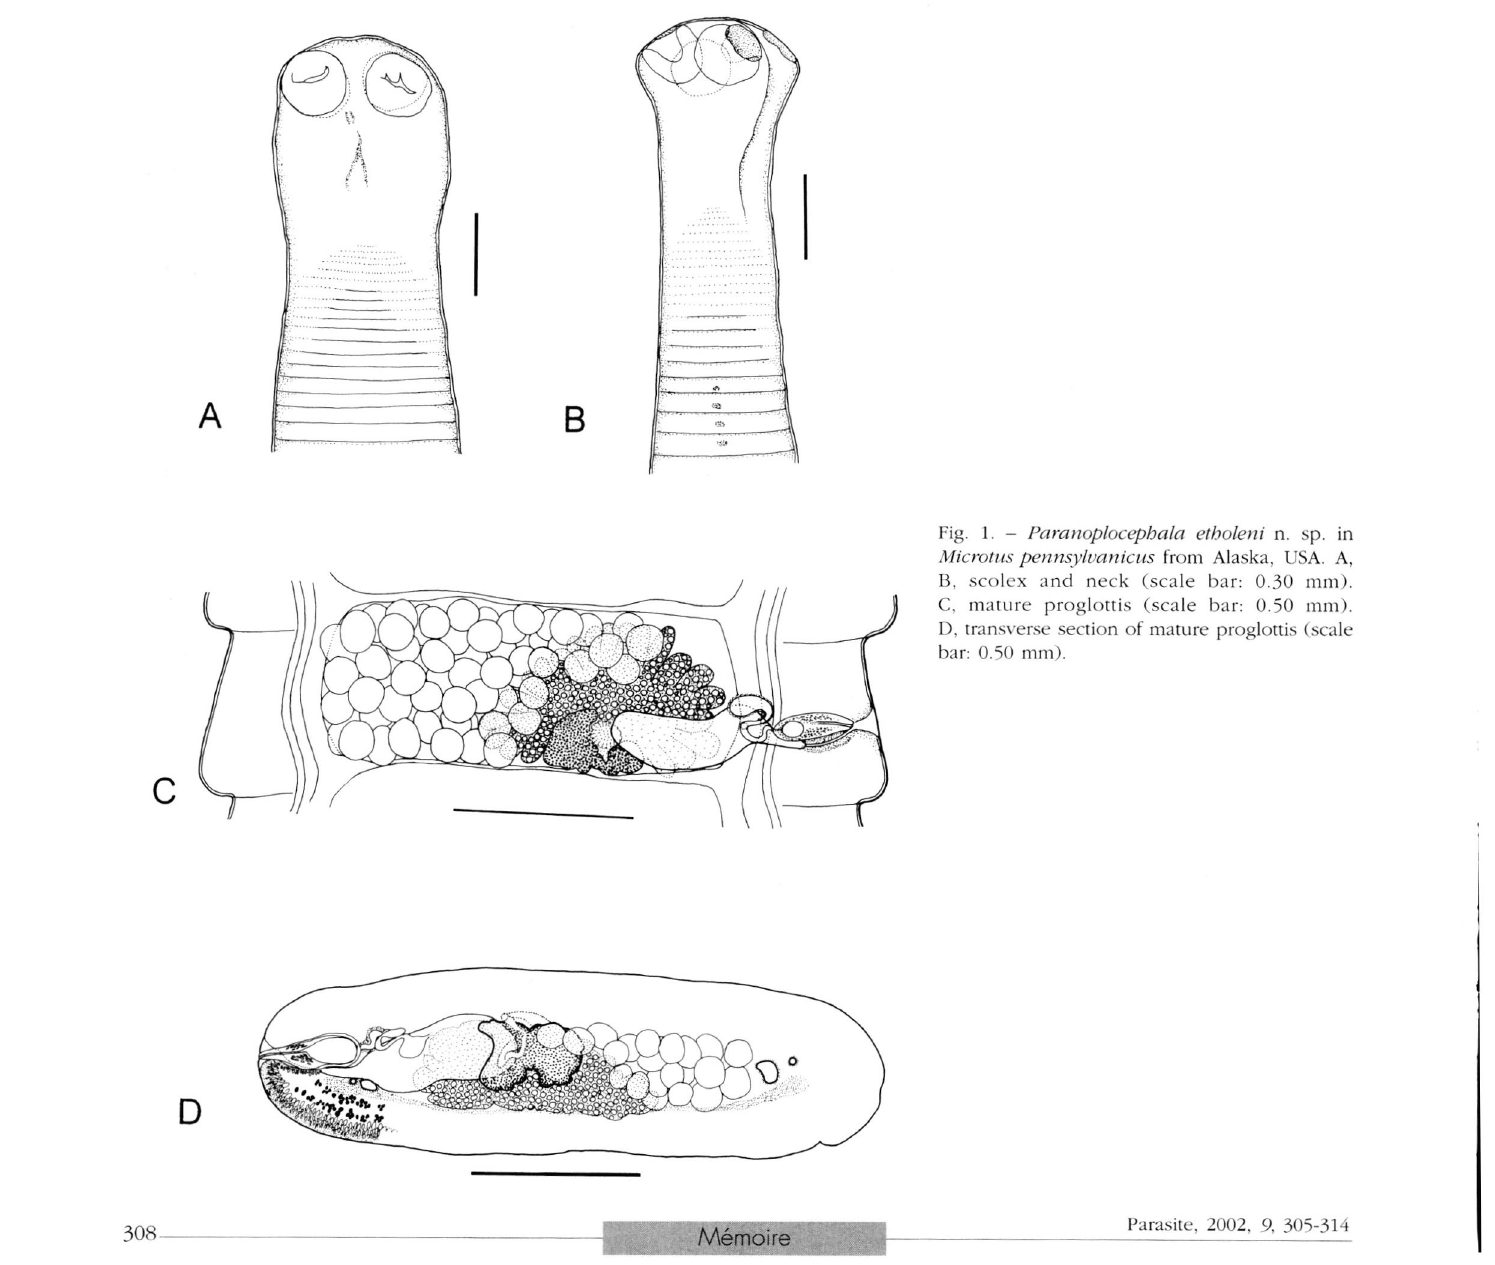
Fig. 1. - Paranoplocepbala etholeni n. sp. in Microtus pennsylvanicus from Alaska, USA. A, B, scolex and neck (scale bar: 0.30 mm). C, mature proglottis (scale bar: 0.50 mm). D, transverse section of mature proglottis (scale bar: 0.50